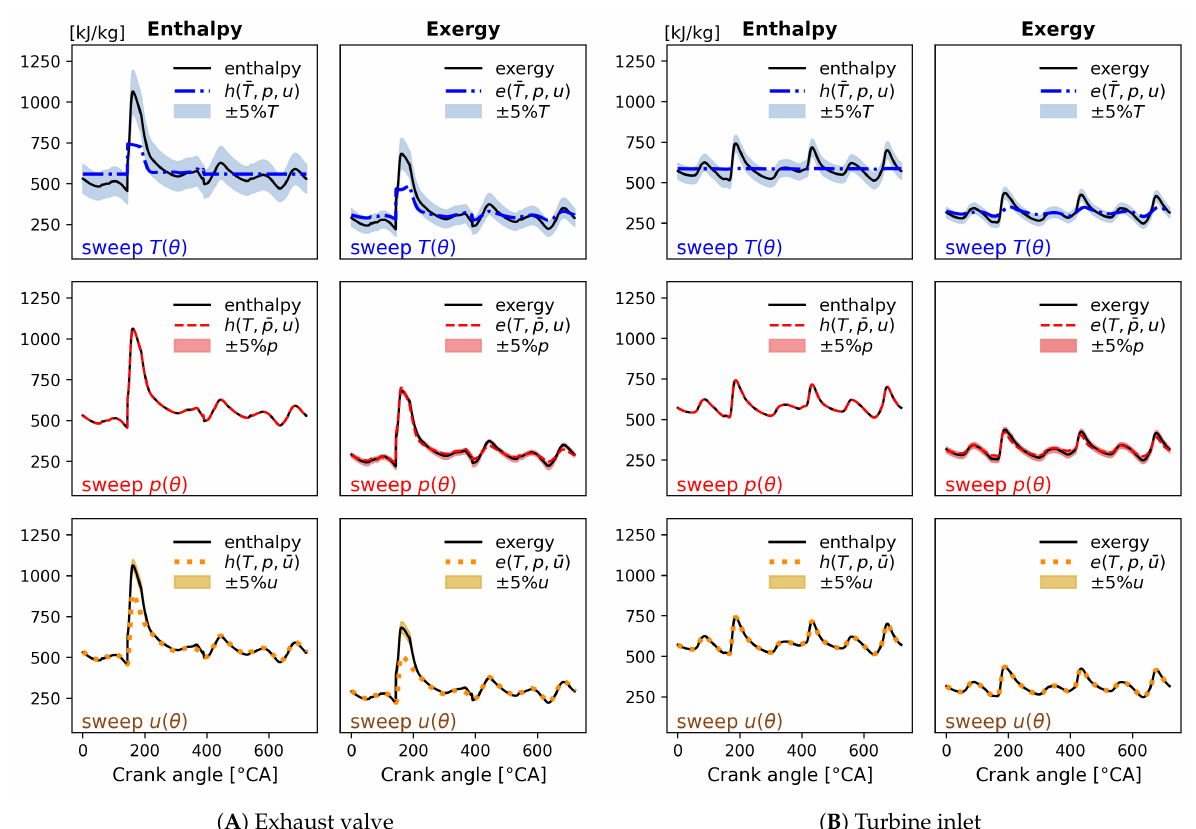
Figure 10. Local sensitivity analysis on the specific enthalpy and exergy pulsations (y-axis unit: kJ/kg) at the exhaust valve and operating at test point (a) 1300 rpm/17.8 nIMEP. From top to bottom, the shaded area in each subplot shows the deviations of enthalpy and exergy pulses caused by the variations in T , p , and u . The black curve represents the “true” enthalpy and exergy as a reference, while the dashed curves result from using the cycle-averaged value of each corresponding flow